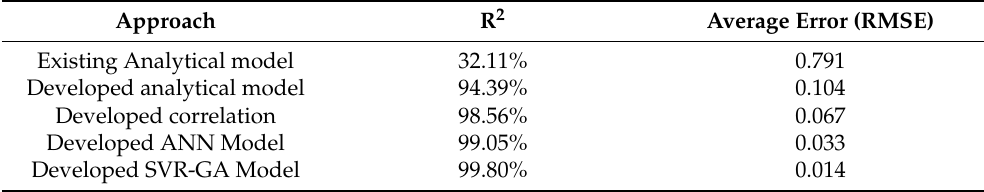
Table 5. Comparison between the existing and developed